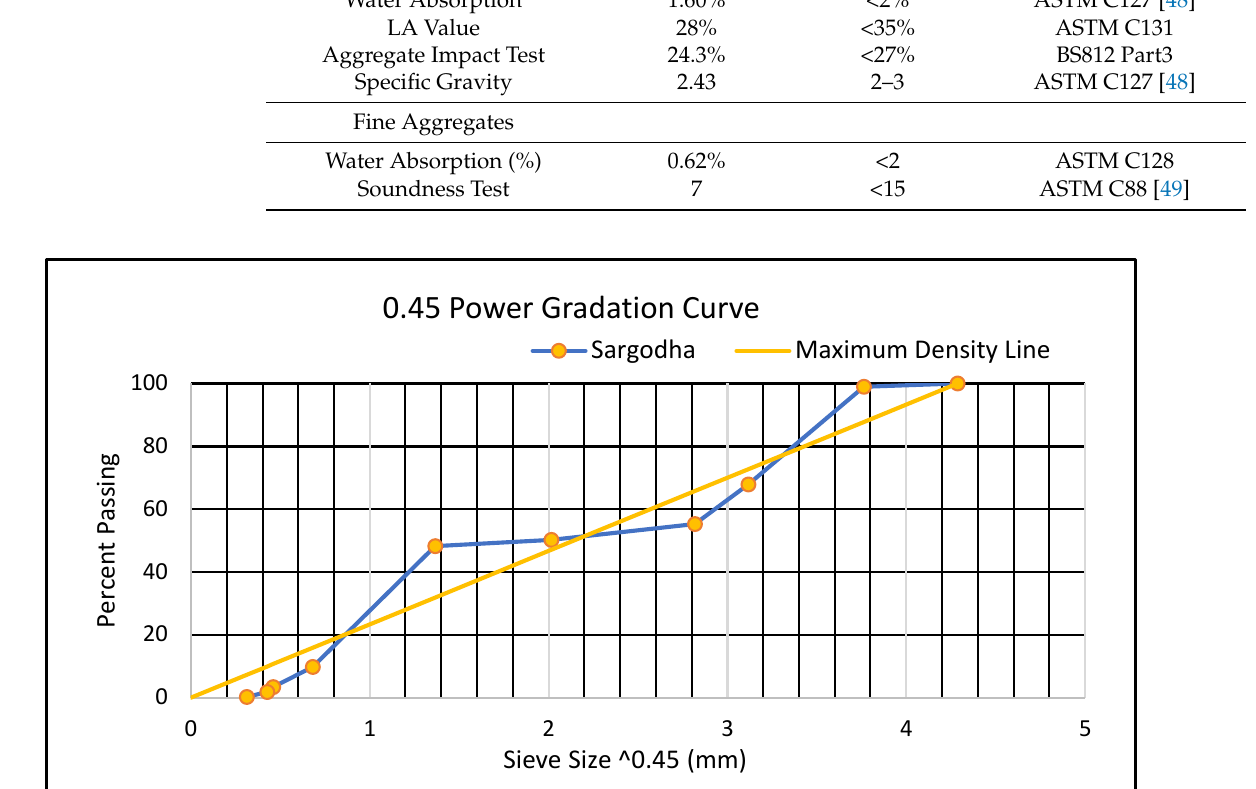
Figure 5. Particle size distribution curve for utilized aggregates (Sargodha type) .